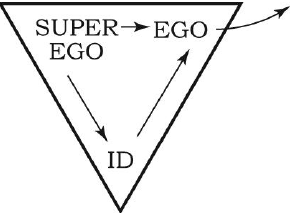
Figure 10: the Freudian Triangle The Script Level Drama Triangles